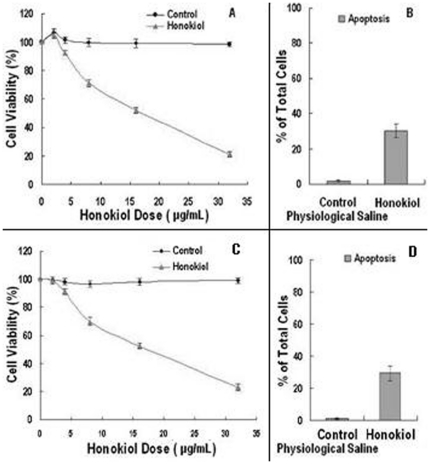
Honokiol inhibited the growth and induced apoptosis in rat 9L gliosarcoma and human U251 glioma cells.A and C, Dose-dependent inhibition of 9L gliosarcoma and U251 glioma cells growth, respectively: cells were exposed to various doses of honokiol for 24 h; B and D, Apoptosis of 9L gliosarcoma and U251 glioma cells, respectively: cells were treated with 16 µg/mL honokiol for 24 h.